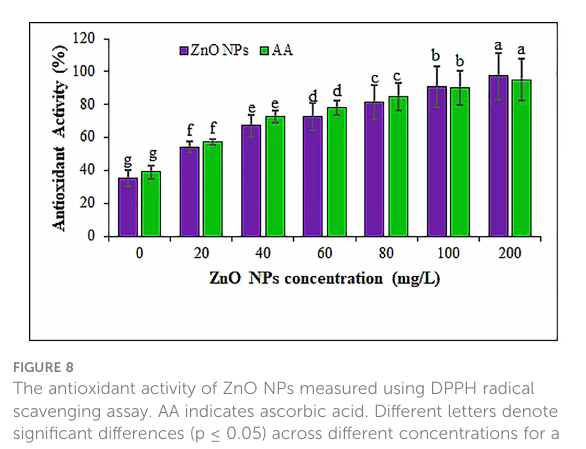
FIGURE 8 The antioxidant activity of ZnO NPs measured using DPPH radical scavenging assay. AA indicates ascorbic acid. Different letters denote signi fi cant differences (p ≤ 0.05) across different concentrations for a particular antioxidant. Values are mean standard error.